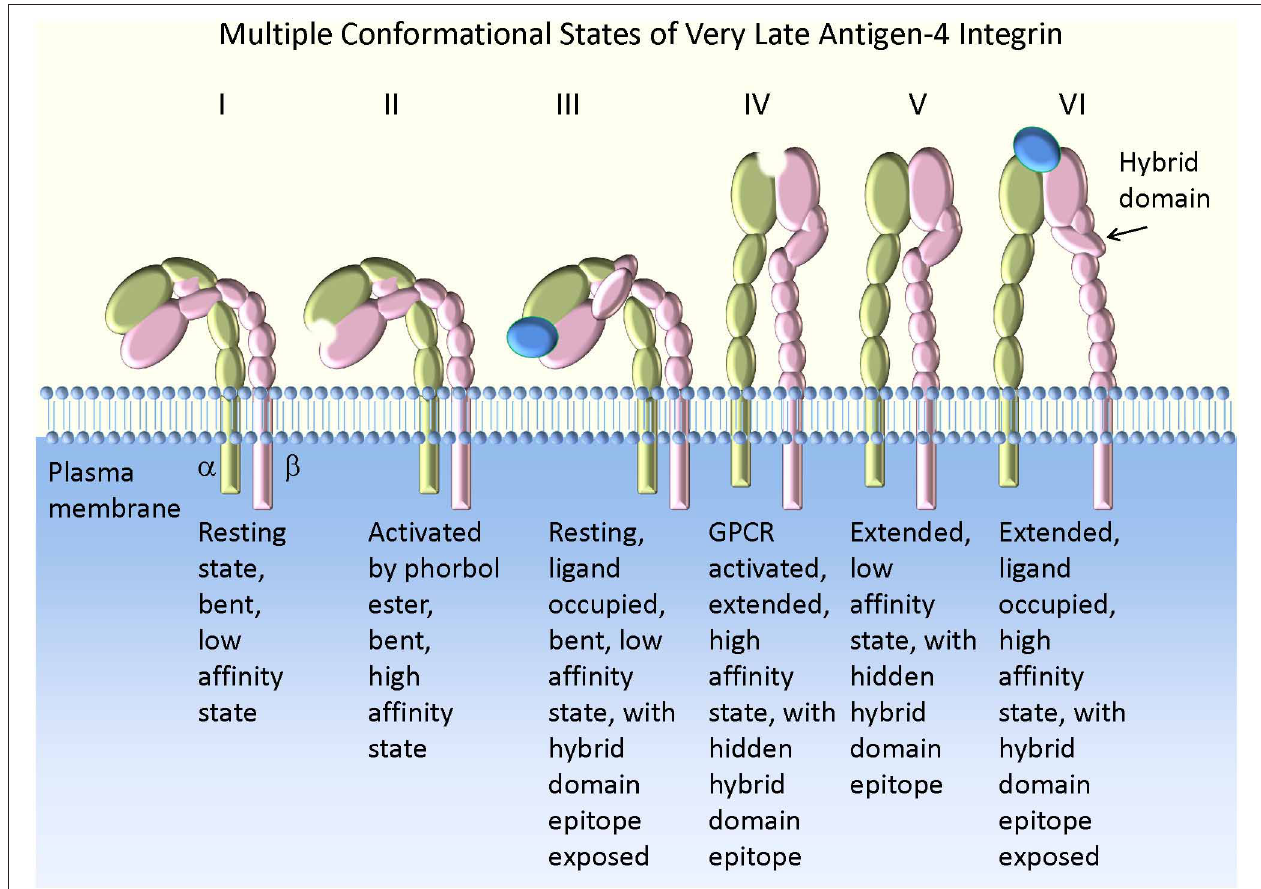
FIGURE 1 | Model of VLA-4 integrin conformation and affinity. The bent low affinity state is observed on resting cells (I). Activation by phorbol ester creates a high affinity state lacking molecular extension as detected by a FRET-based approach (II). This conformation results in the slow accumulation of cell aggregates in suspension (Chigaev et al., 2007), with a low tether capture frequency but a long tether duration in the rolling assay ( Table 2 ). The addition of VLA-4 specific ligand to resting cells leads to exposure of a hybrid domain (LIBS) epitope (III). However, the ligand binding affinity remains low [see Figures 2, 4 in Chigaev et al. (2009)]. This state is bent (or at least not fully extended) because a further molecular extension can be detected with a FRET-based approach (Chigaev et al., 2003a, 2004, 2007). Activation through a wild type G α i-coupled GPCR induces a high affinity extended conformation (IV). This conformation results in the rapid accumulation of cell aggregates in suspension (Chigaev et al., 2007), with high tether capture frequency and long tether duration ( Table 2 ). The low affinity extended (or at least partially extended) conformation (V) can be detected for several minutes after signaling from wild type G α i-coupled GPCR, because of relatively faster